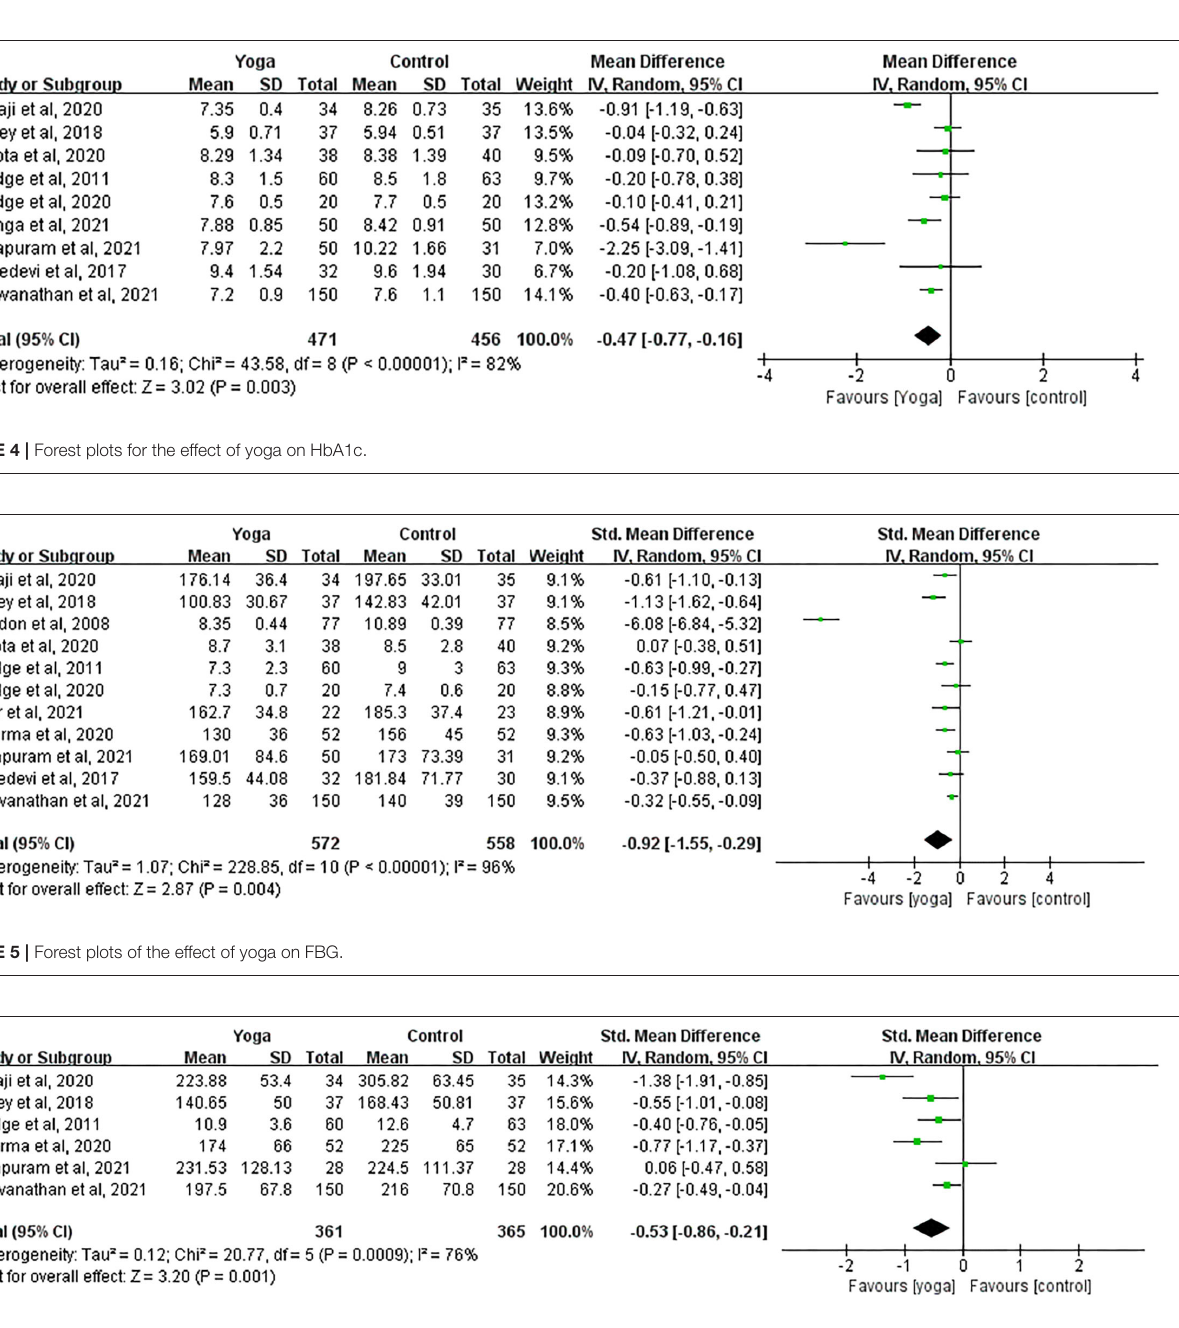
FIGURE 6 | Forest plots of the effect of yoga on PPBG.